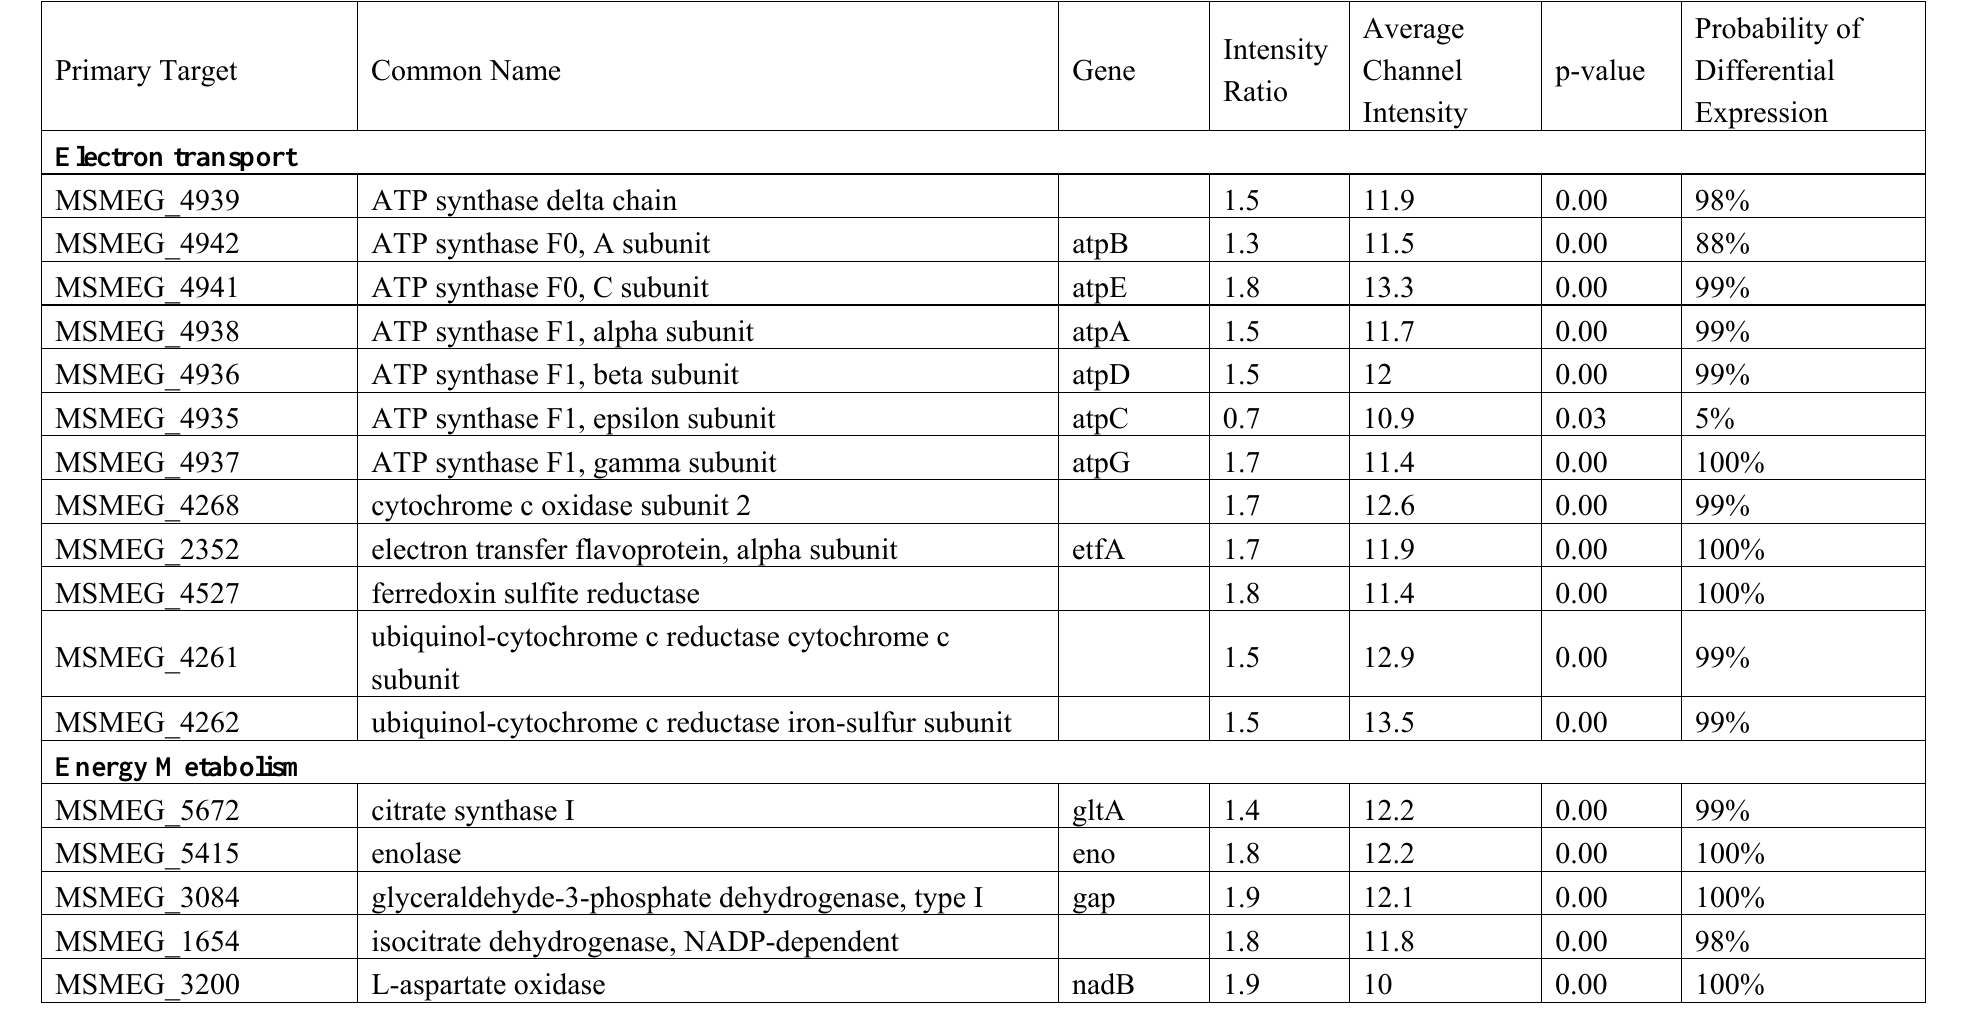
Appendix Table 2. Select up-regulated operons and clusters in log phase over stationary phase (non-spray dried log versus stationary